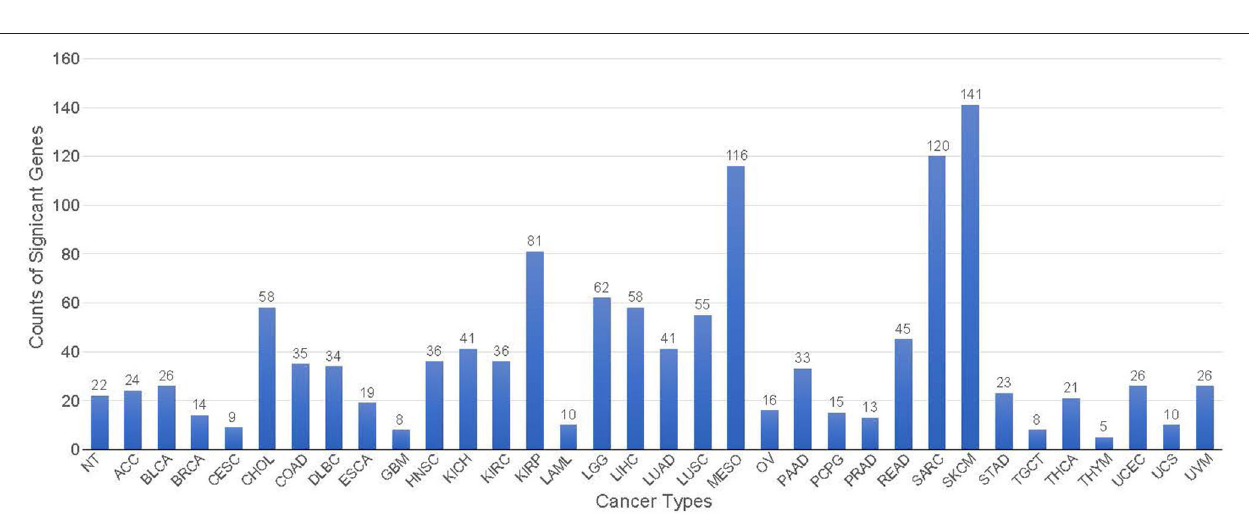
FIGURE 8 | Confusion matrix of all samples predicted by the coexpression + singleton GCNN model with combined 33 different cancer types and normal samples.